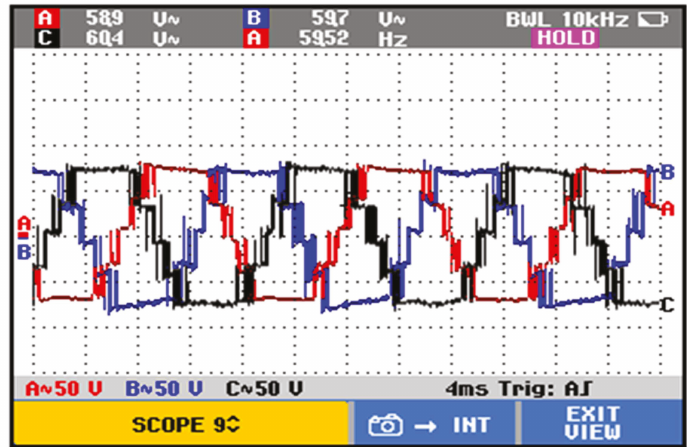
Figure 17: Experimental three-phase voltages generated from con fi guration A.